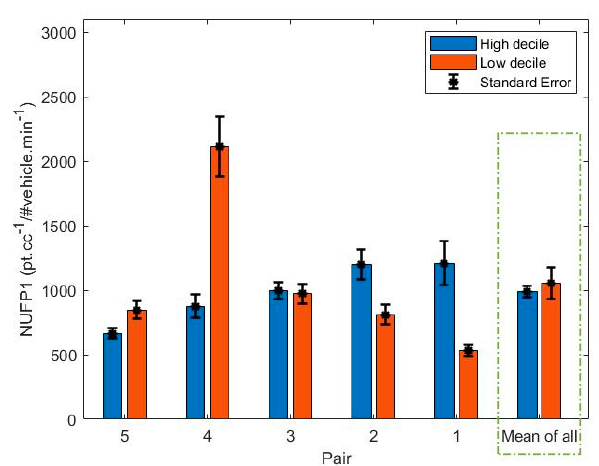
Figure 9. Bar plot of NPNC1 for each pair.